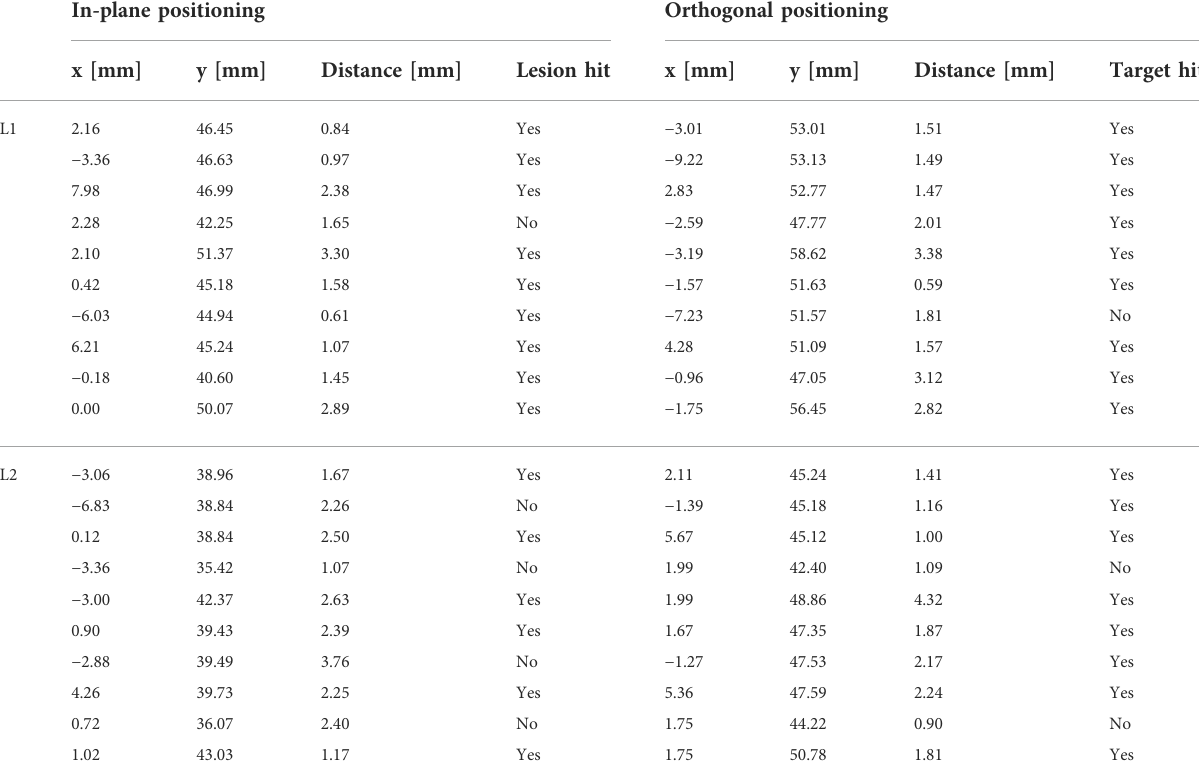
TABLE 3The 2Dpositioning errorsfor in-plane andorthogonalpositioning forlesionsL1andL2in theabdominalphantom. Theclickpositionsofthe planned targets are provided as x and y coordinates within the US image. A binary assessment of hitting/missing the lesion is included. In-plane